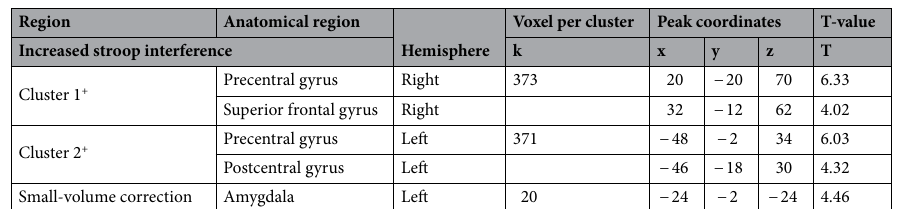
Table 4. Clusterwise statistics of the functional connectivity analysis of covariance of the individual stroop score (reduced stroop interference) with the FUN > TYP contrast. All reported regions were corrected for multiple comparisons on a cluster threshold of p < 0.05, voxel threshold p = 0.001, k = 47 voxel. Clusters which survived a FDR-correction are indicated by a + . Coordinates are reported in MNI space.